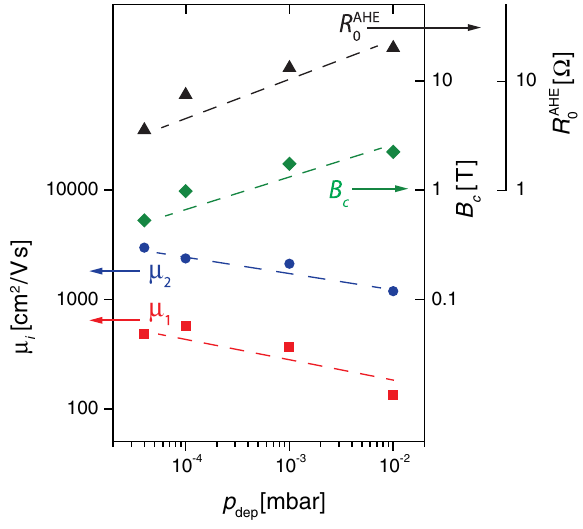
FIG. 10. Summary of anomalous and conventional transport parameters obtained at 2 K as a function of p . While the dep quantities characterizing the AHE increase with increasing p , the electron mobility characterizing the defect structure dep shows the inverse dependence on p . The dashed lines are guides dep to the eye.